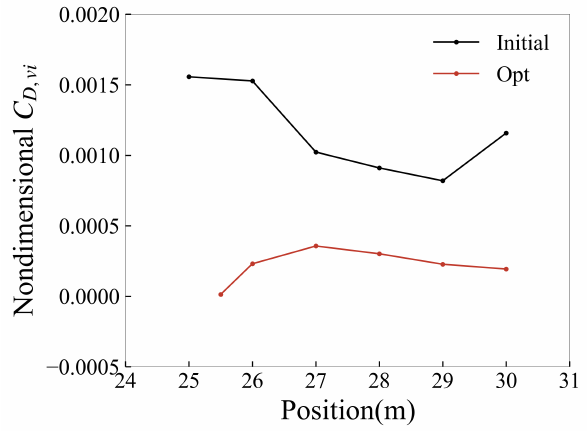
Figure 26. Nondimensional vortex-induced